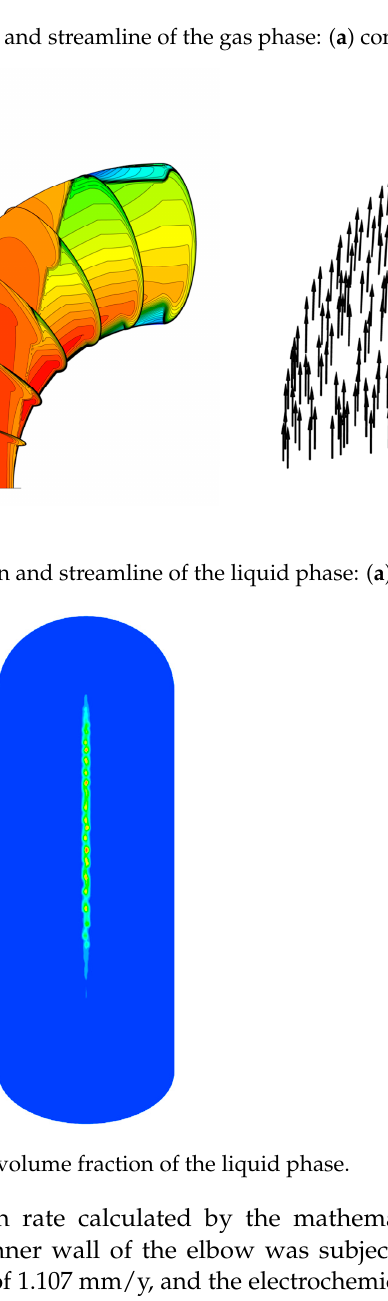
( c ) Figure 12. Distribution of the corrosion rate: ( a ) view from +Y; ( b ) view from +X; ( c ) view from − Y of the elbow.